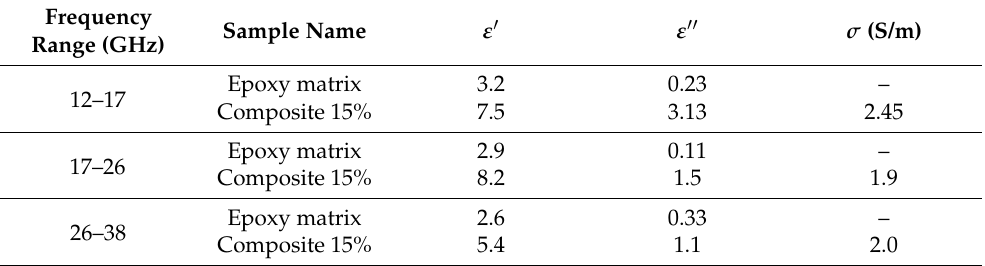
Figure 6. Frequency dependences of the permittivity of the composite with 3.8% flakes and 2% CNT in the frequency range from 26 to 38 GHz ( a ); in the frequency range from 53 to 78 GHz ( b ). Table 2. Summary of estimates of the complex permittivity results and specific electrical conductivity of the samples, averaged over the measurement frequency ranges.